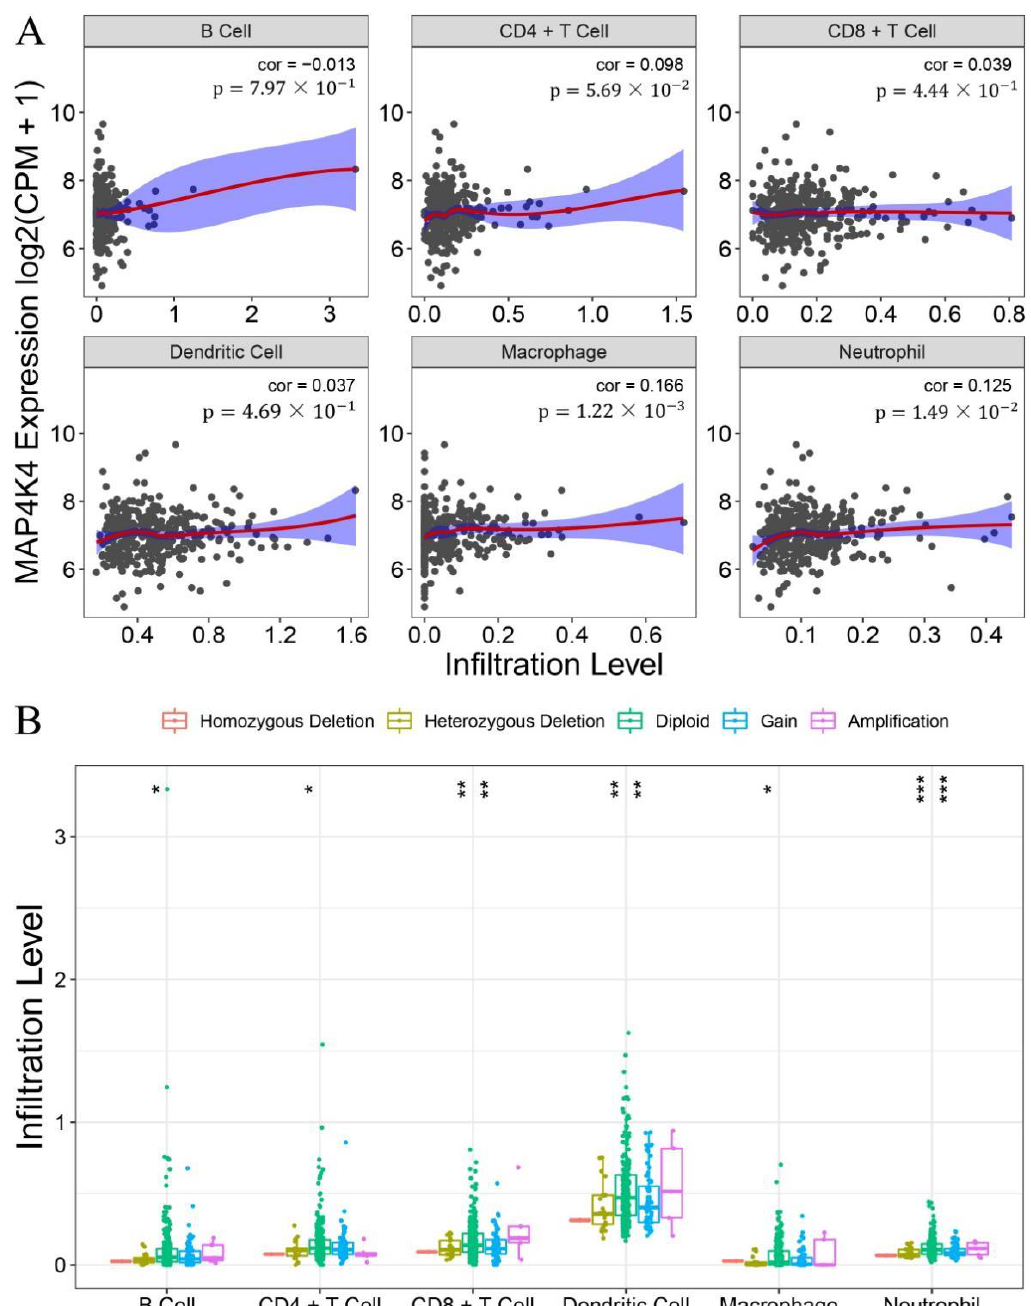
Figure 2. Statistics of cellular immune infiltration and corresponding copy number variation data in corresponding diseases. ( A ) the Spearman correlation between MAP4K4 expression and the immune infiltration level of 6 types of immune cells; ( B ) the CNV classification of MAP4K4 in the immune infiltration level of 6 types of immune cells. Herein, in Figure 2B, * represents the significance level that is analyzed using multivariant analysis. (* FDR < 0.05, ** FDR < 0.01, *** FDR <